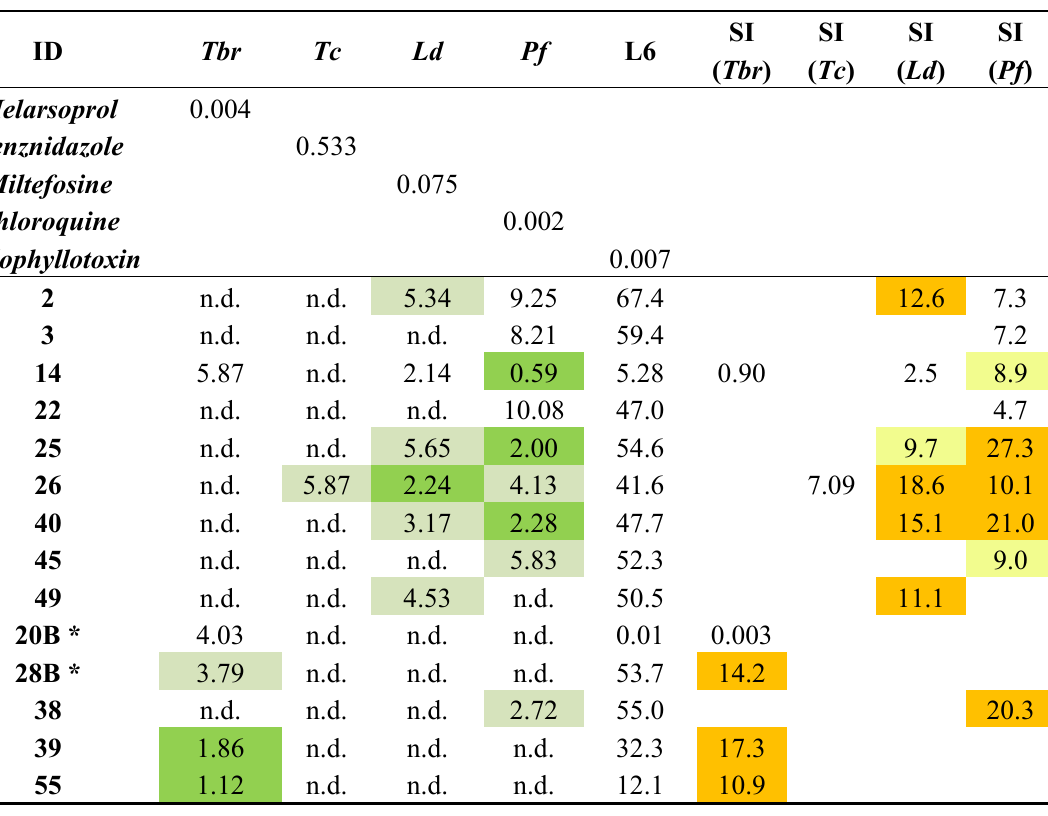
Figure 1. Distribution of the dataset of 58 extracts over the four biological activities under study at the two tested concentrations. Data represent percent growth inhibition of the various parasites at 10 and 2 µg/mL. Table 1. IC 50 values of active extracts against the most susceptible parasites and for cytotoxicity against L6 cells. All data are expressed in µg/mL and represent the mean of two independent determinations. Highlighted in light green: 2.5 < IC 50 < 10 µg/mL. Dark green: IC 50 < 2.5 µg/mL. Orange: SI > 10. Yellow: 10 > SI > 7.5.